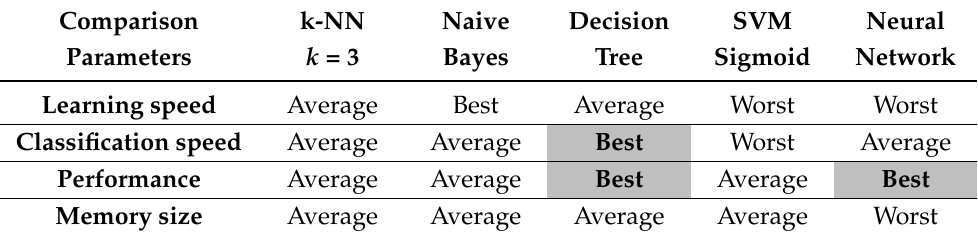
Table 6. Classification algorithms comparative parameters’ study under Stage